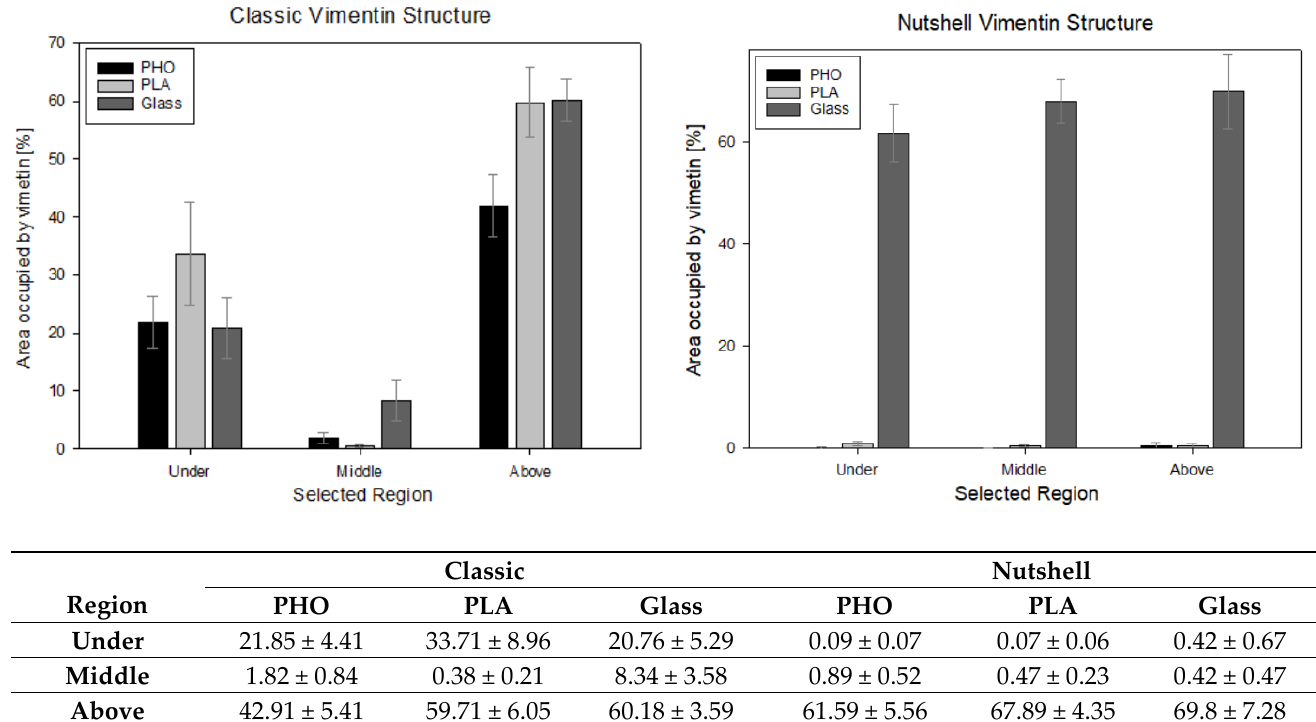
Figure 7. Presentation of the percentage amount of vimentin measured in 10 × 10 µ m squared region of interest (ROI) in the areas under the nucleus, in the middle of the cell’s height, and above the nucleus. The table presents the calculated average values % ± standard error